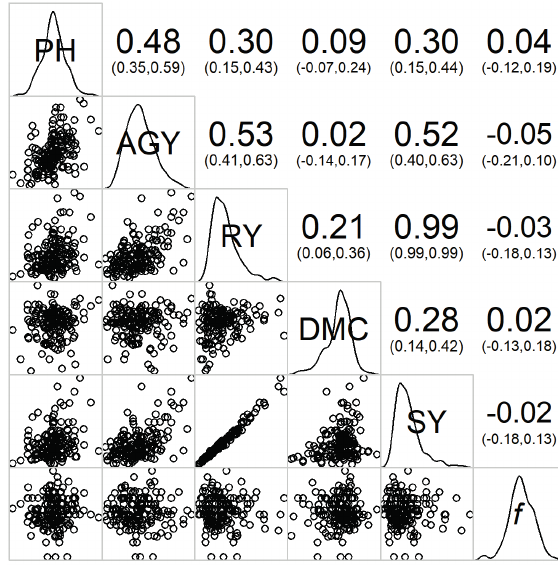
Figure 8 - Pearson correlation estimates for the inbreeding coefficient and agronomic traits in S cassava individuals. PH: 1 plant height (m); DMC: root dry matter content (%); AGY: above ground yield (t.ha -1 ); RY: root yield (t.ha -1 ); SY: starch yield (t.ha -1 ); f : inbreeding